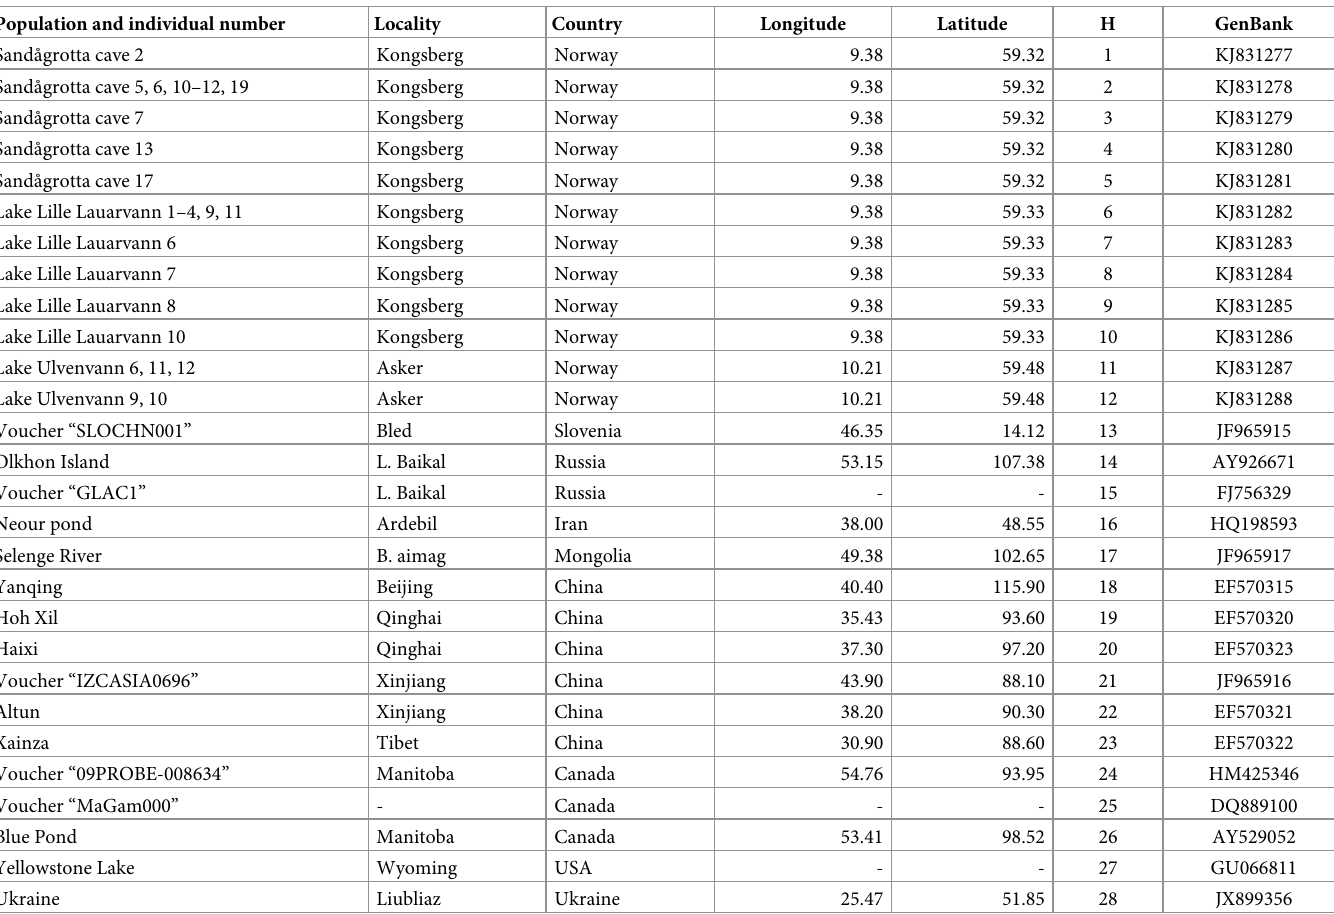
Table 5. The Gammarus lacustris sequences used in comparative phylogenetic analysis. H denote haplotypes. – denotes missing information. Norwegian sequences are deposited in GenBank (with accession numbers KJ831277-88, while remaining sequences are retrieved from GenBank). Outgroup sequences: Gammarus decorosus (Gen- Bank Acc. Number: JF965875), G . lobifer (JF965920), and G . inerbus (JF965902). Population and individual